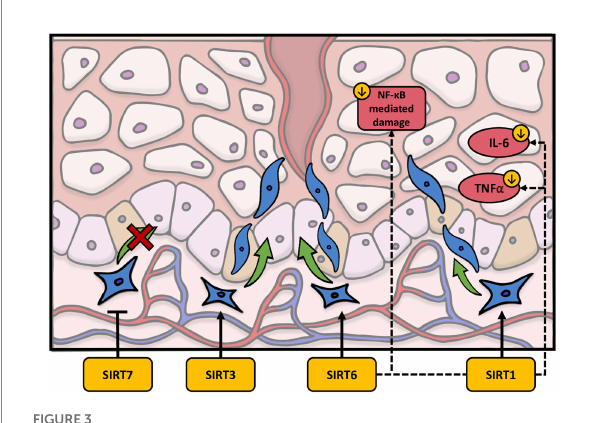
FIGURE 3 The effects of sirtuins on the dermal wound healing process. SIRT1 downregulates IL-6 and TNF α as well as activating fibroblast migration. SIRT3 and SIRT6 have also been shown to promote fibroblast migration. Finally, SIRT7 may inhibit fibroblast